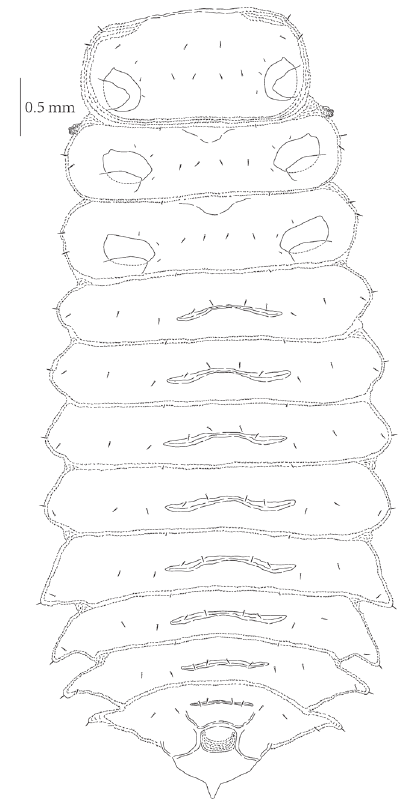
Figure 18. Prionispa champaka , last instar larva, ventral view.